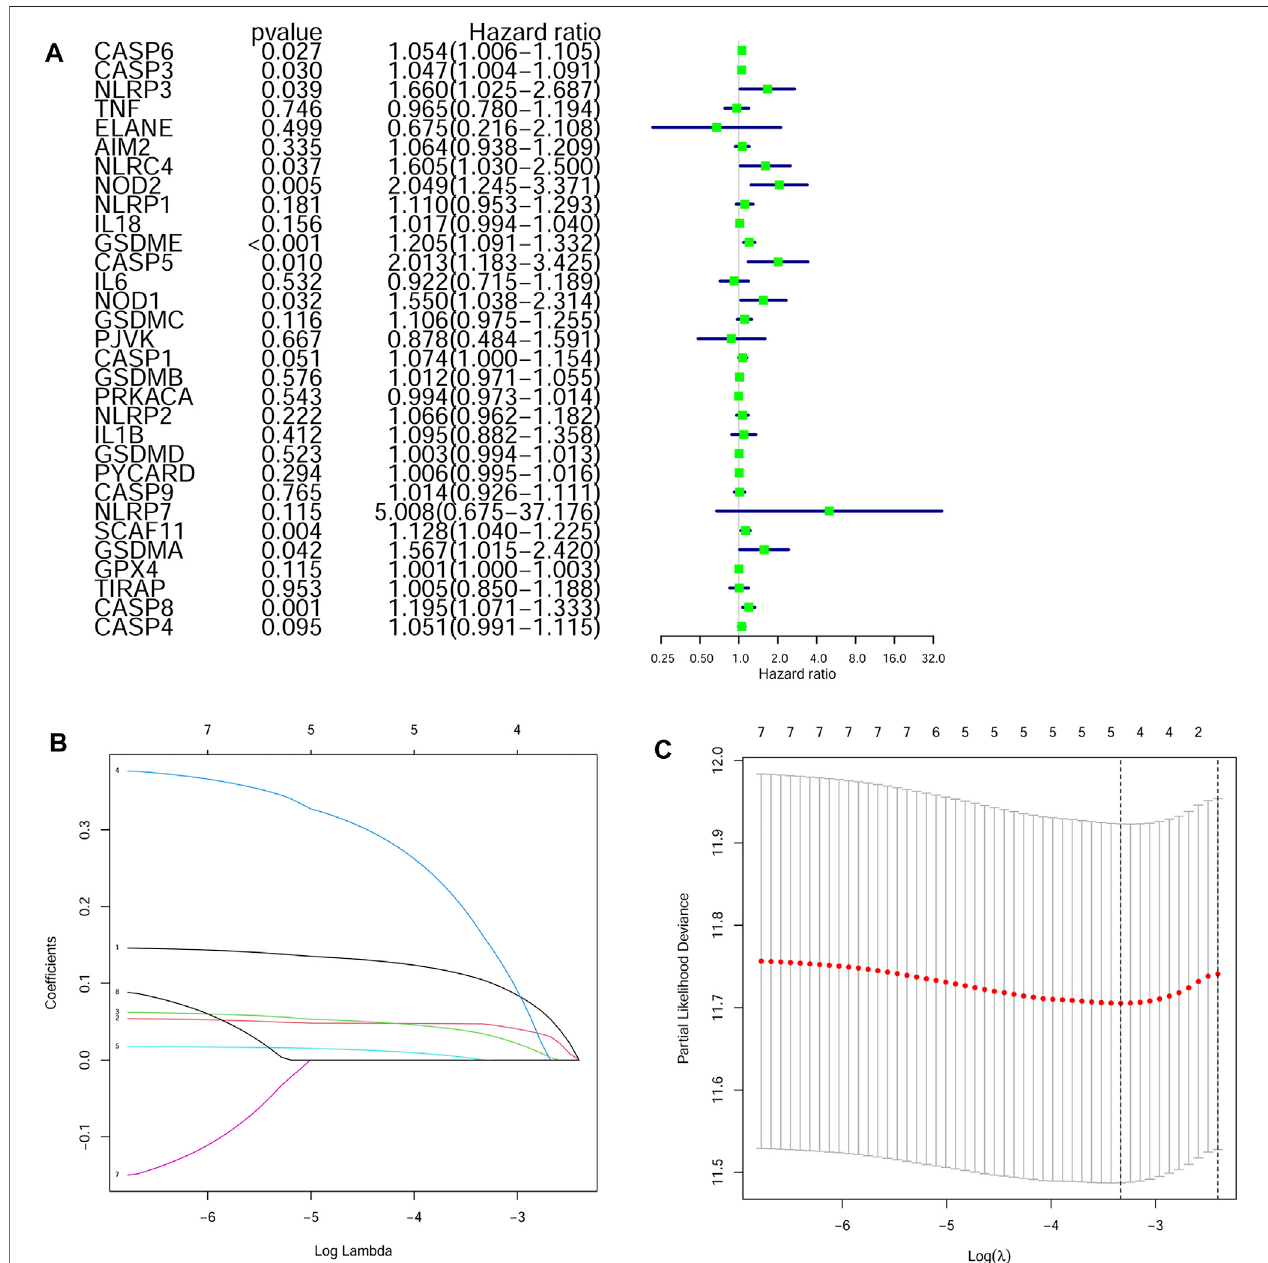
FIGURE 3 | Construction of a LASSO regression model (A) Univariate cox regression analysis identi fi ed the prognostic related genes (B) LASSO regression of the eight prognostic genes (C) Cross-validation of the LASSO regression.